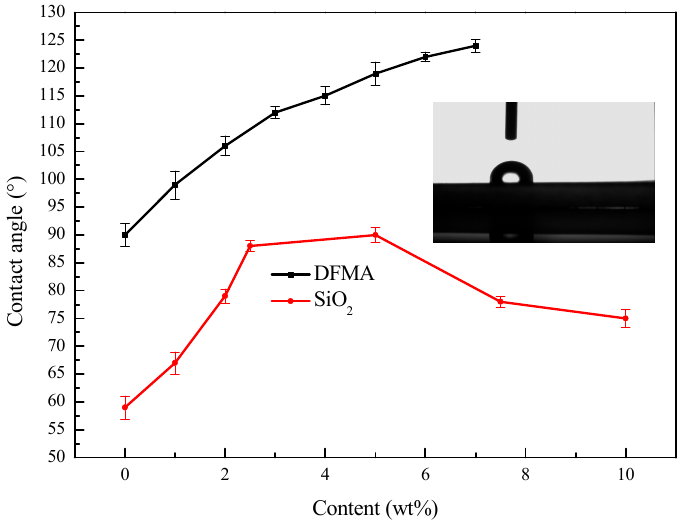
Figure 8. Effects of DFMA and modified Nano-SiO 2 dosages on contact angles of latex films.